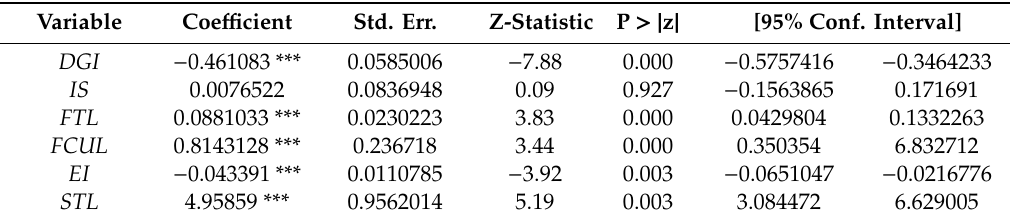
Table 8. Tobit regression